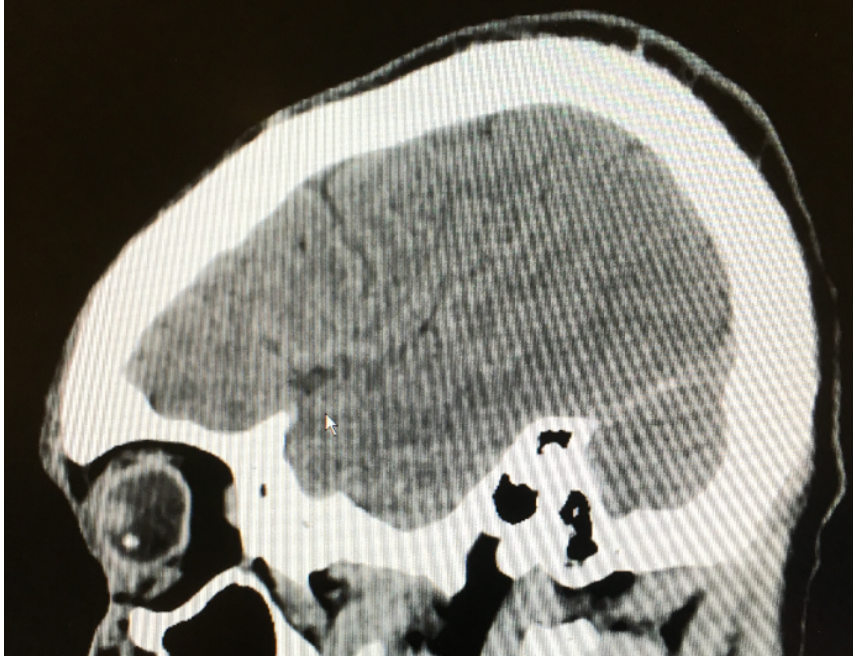
Figure 2: A foreign body seen within the globe on CT-imaging IOFB was approximately 3.5 mm in greatest dimension (Figure 3) and the second measured around 2 mm. As the composition of the foreign bodies were unknown at the time, intravitreal vancomycin and ceftazidime were administered.